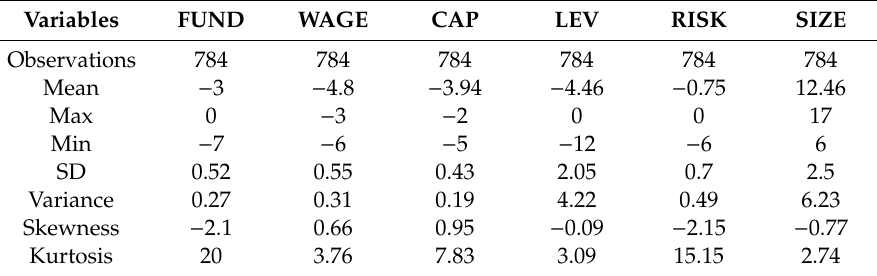
Table A2. Statistics for control